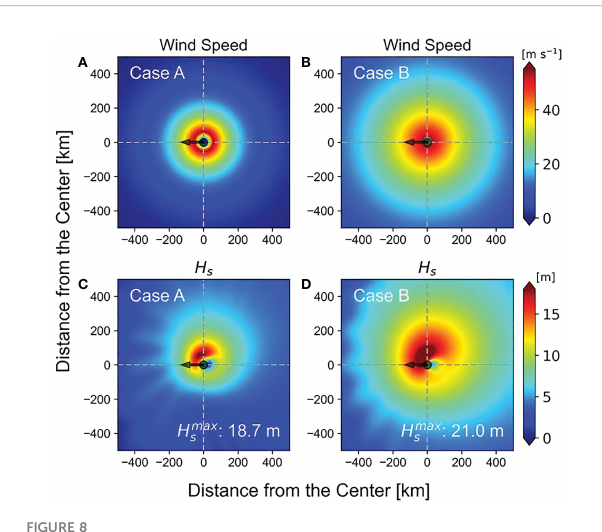
FIGURE 8 The spatial distribution of wind speed (A, B) and signi fi cant wave height (C, D) for the two examples in Figure 1. Here, Case A (A, C) has a larger RMW but a smaller R64, R50, and R34 than Case B (B, D) . The TCs in both cases translate with a constant speed ( V fm = 5.25 m s -1 ) and MWS of 105 knots. Arrows indicate the direction of propagation of the storm.